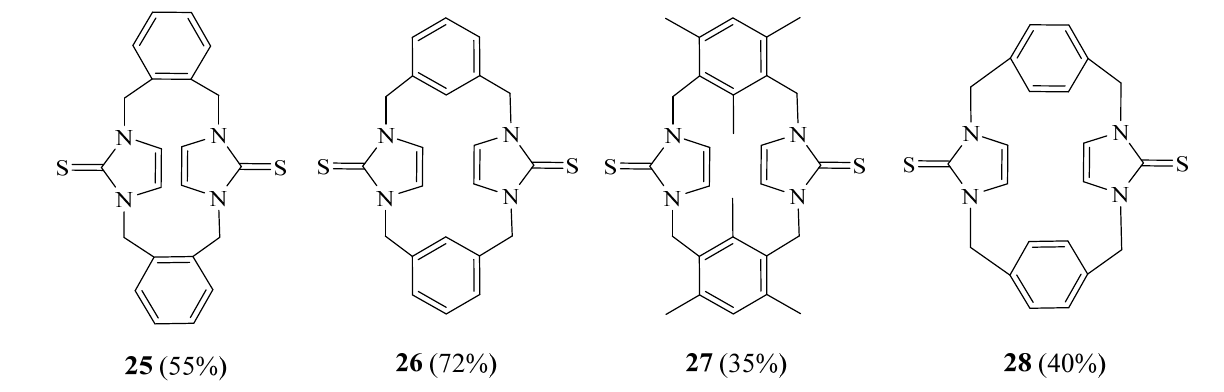
Figure 7. Structures of cyclophanes 25 − 28. (Reprinted with permission from ref. [22]. Copyright 2018 Elsevier).